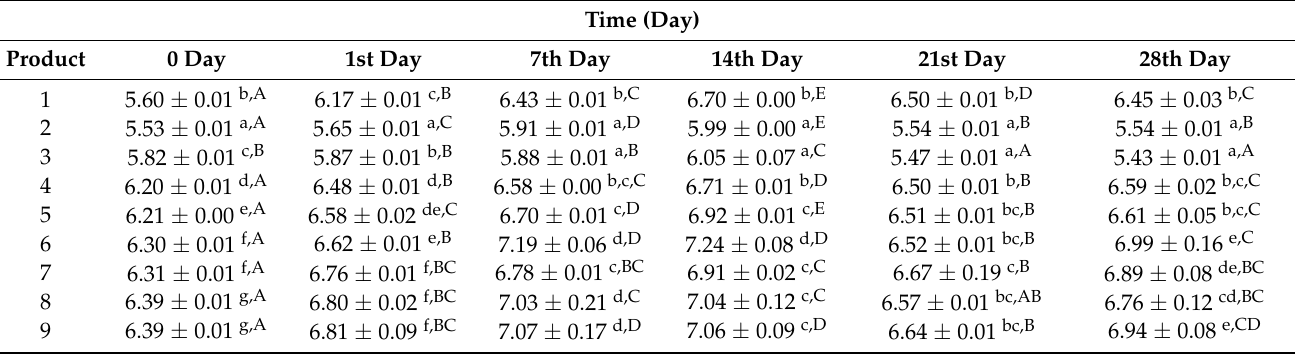
Table 3. Effect of addition of FM, GA and yogurt culture and Bifidobacterium lactis at different concentrations on B. lactis count (log CFU/ mL) in kefir samples during storage